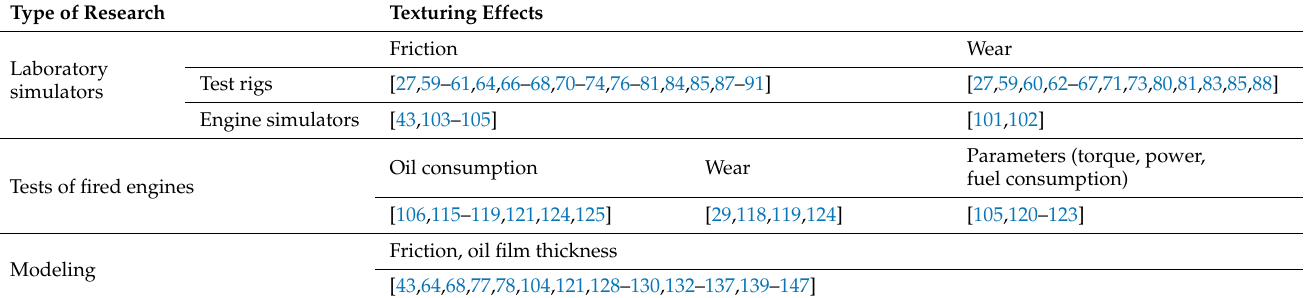
Table 1. Research presented in